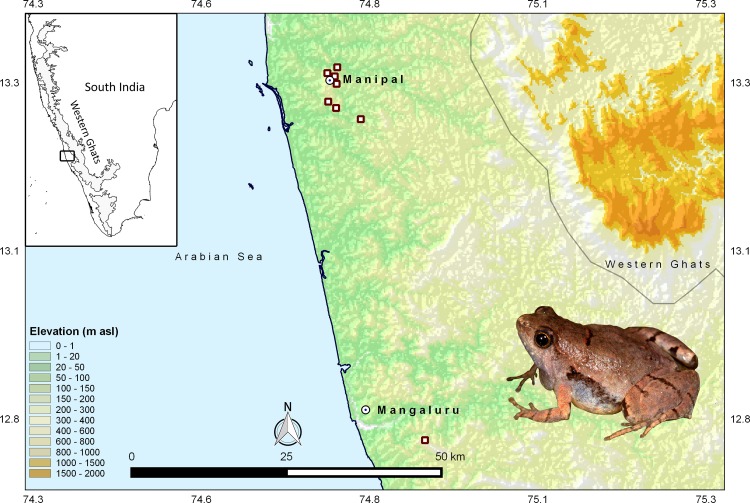
Map showing type locality of M. laterite sp. nov.White box with maroon outline: M. laterite sp. nov. Grey line indicates Western Ghats Boundary. Maps were generated using QGIS® Pisa Ver. 2.10. Data was sourced from www.gadm.org for administrative boundary of India and Shuttle Radar Topography Mission (SRTM) 90 m database (http://srtm.csi.cgiar.org) for elevation.